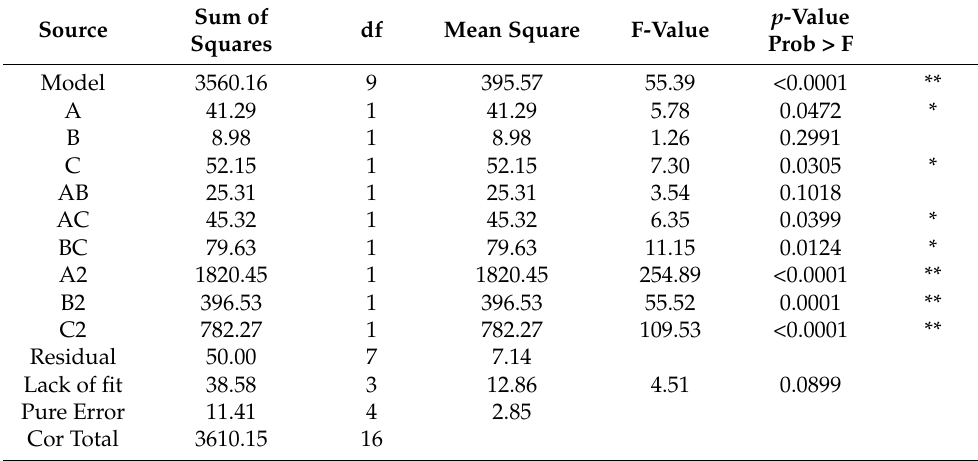
Table 3. Significance and variance test